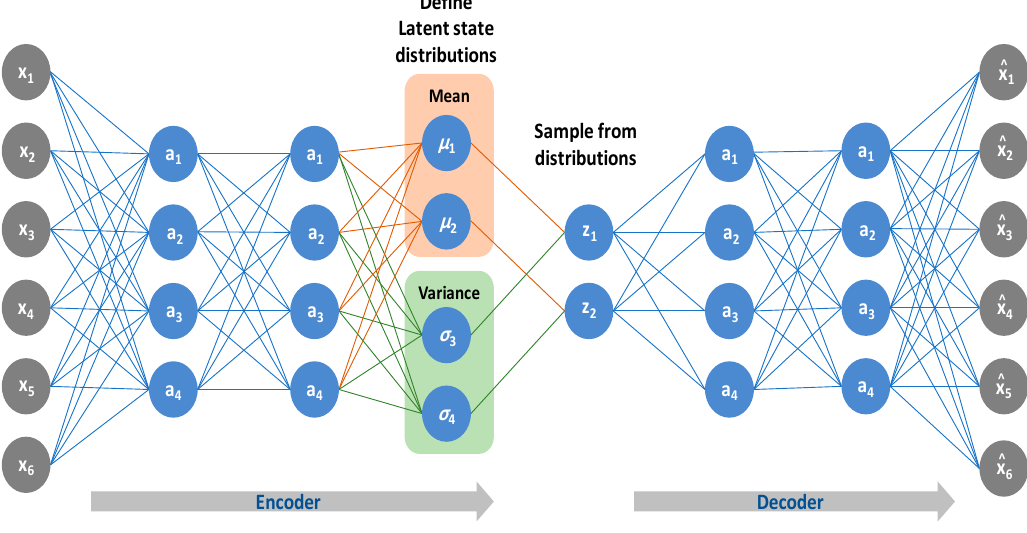
Figure 8. A representation of a variational autoencoder [52]. A backpropagation technique is used to calculate the relationship between each param- eter and the final output loss during the training process. By using the re-parameterization trick, a random sample, ε , from a unit Gaussian distribution can be taken, shifted by the latent distribution’s mean, µ , and scaled by the latent distribution’s variance, σ as shown in Figure 9